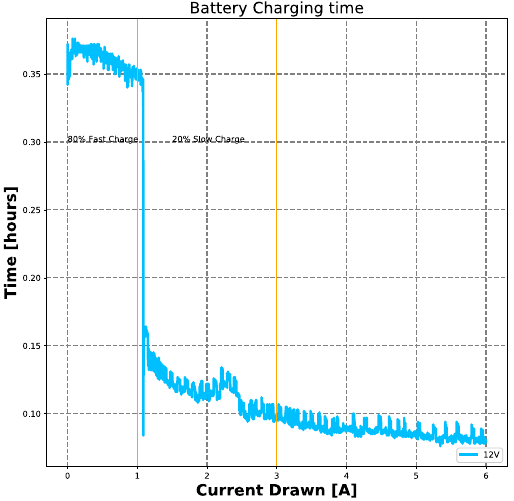
Figure 22. Graph of the battery charge time.